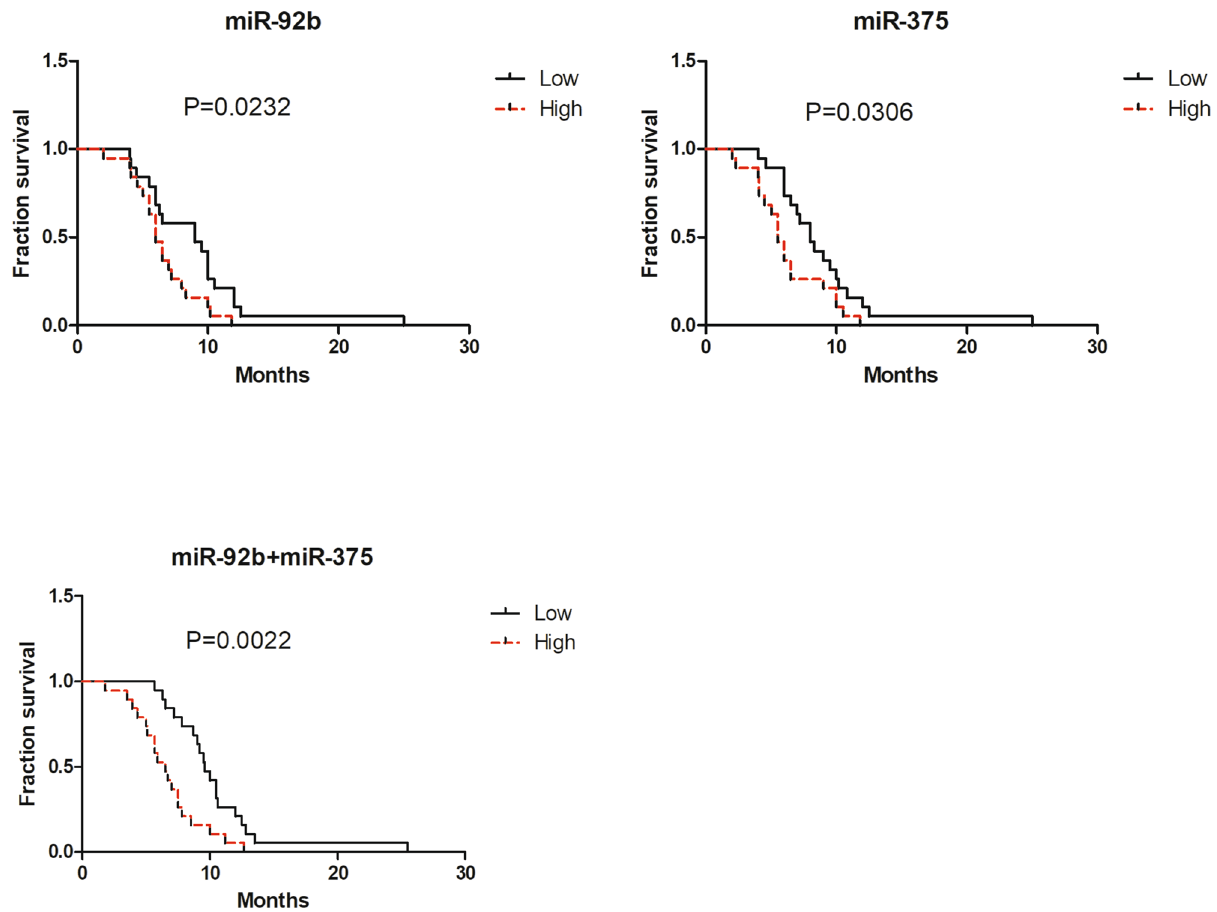
Figure 6. Kaplan–Meier curve for progression-free survival (PFS) for SCLC patients with high levels of miRNAs versus SCLC patients with low levels of